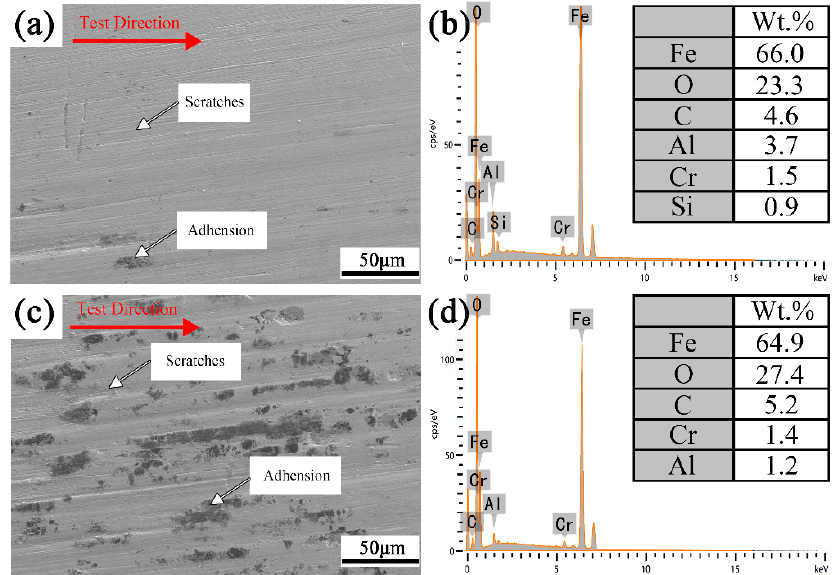
Figure 10. Morphological and adhesive composition analysis of the surface of the H13 steel after friction, ( a ) SEM image of the surface after friction with 10Mn5 steel, ( b ) EDS analysis of the black adhesion in ( a ), ( c ) Scanning electron microscope image of the surface after friction with 22MnB5 steel, ( d ) energy spectrum analysis of the black adhesion in ( c ). ( b , d ) shows the oxides on the surfaces of the samples were transferred to the surfaces of the mold during sliding.